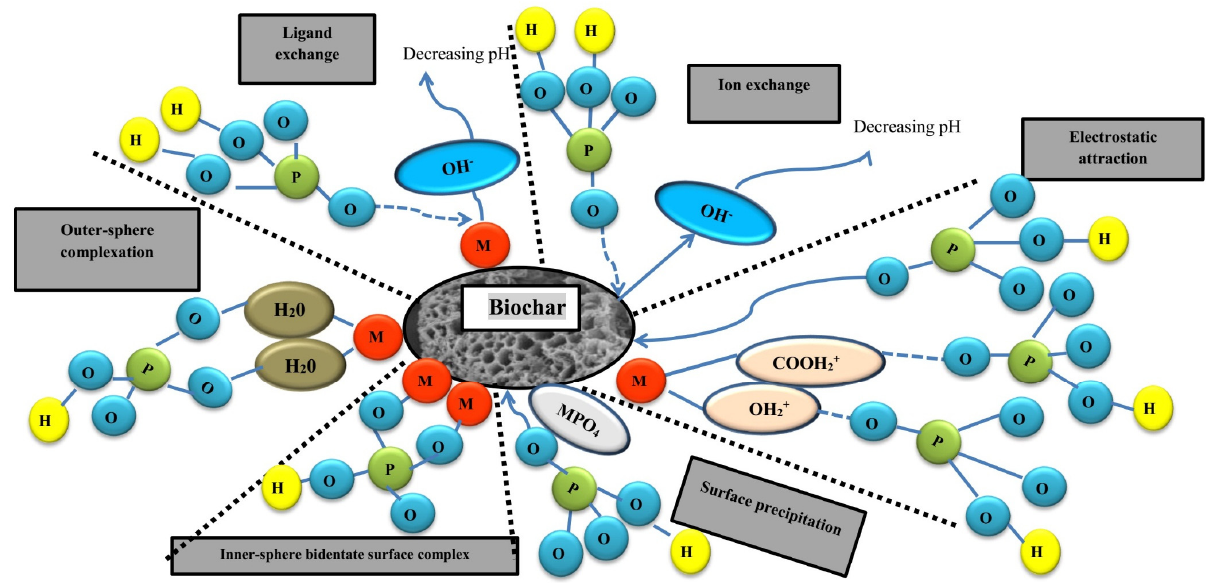
Figure 4. Potential mechanisms for P sorption onto biochar surface (M: metal cation).